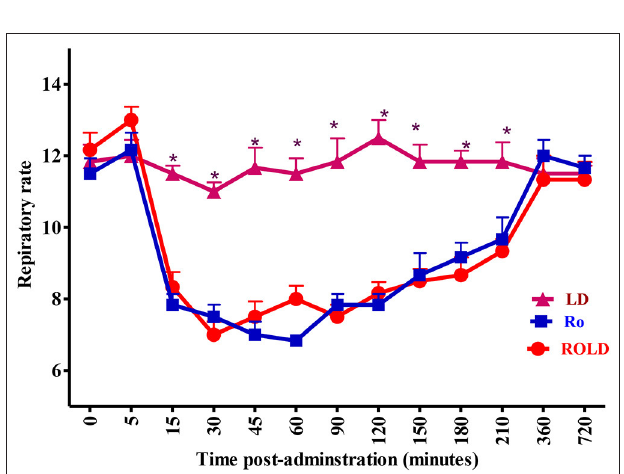
FIGURE 4 | Respiratory rate (respiratory cycle/min; mean ± SE) pre-epidural and post-epidural injection of romifidine (RO) (50 µ g/kg), romifidine-lidocaine (ROLD) (50 µ g and 0.3mg /kg) and lidocaine (LD) (0.3 mg/kg) in camels ( n = 18). *Significant at P <